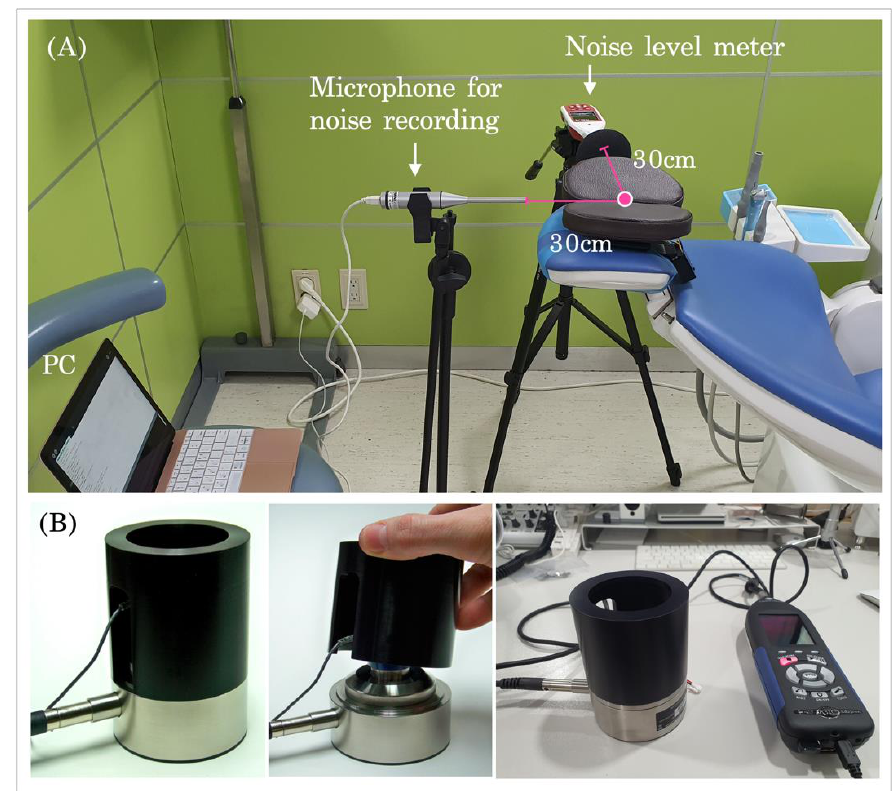
Figure 2. Apparatus and task method for the handpiece noise analyzing: ( A ) noise recording and measurement method; ( B ) calibration by audiometer.